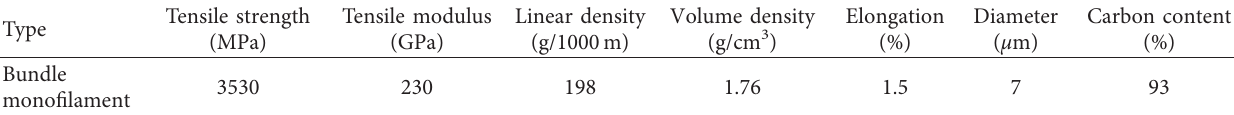
Table 1: Basic physical and mechanical properties of carbon fiber.